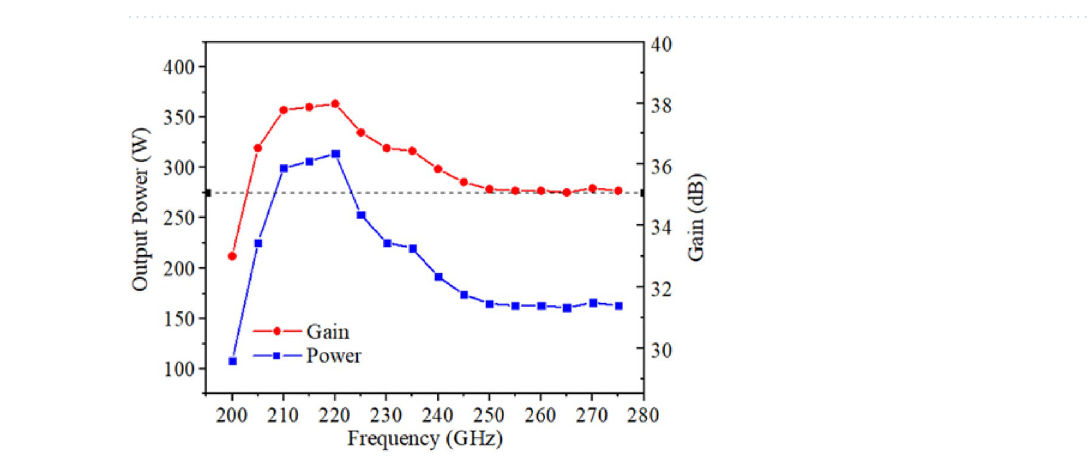
Figure 23. Bandwidth of output power and gain of the whole SDV-TWT.